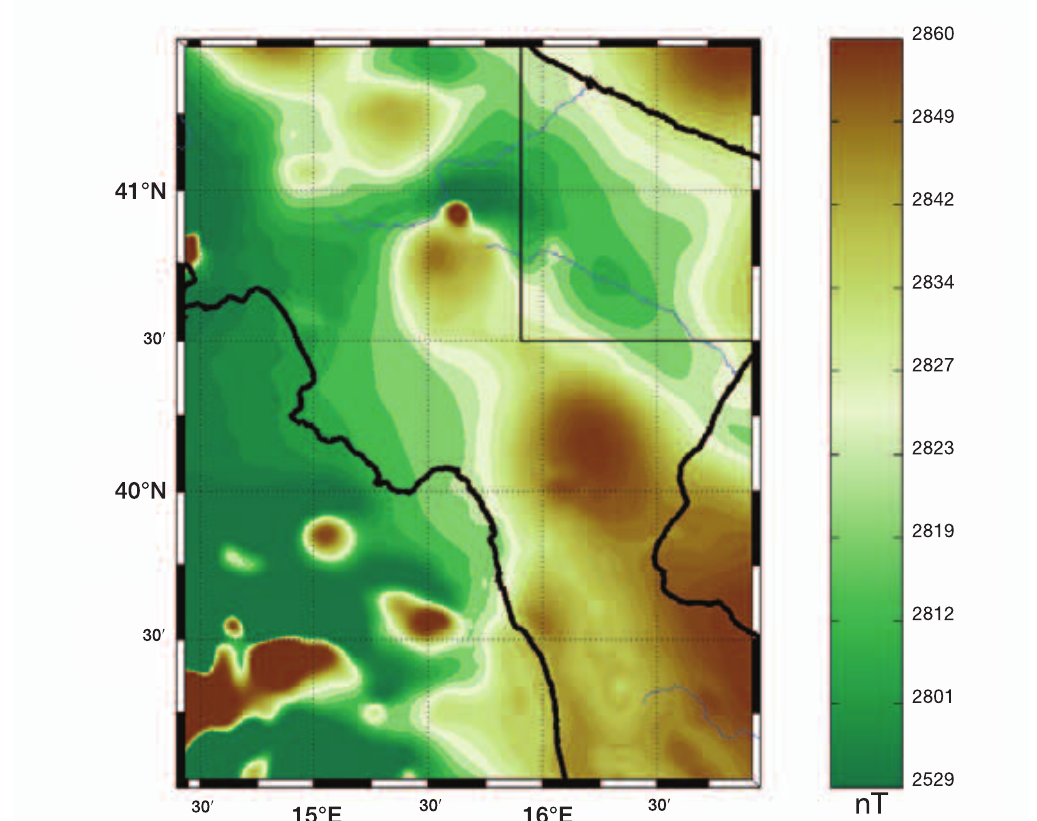
Fig. 5. Aeromagnetic anomaly field of Southern Italy (AGIP survey, 1980). Grid step = 2